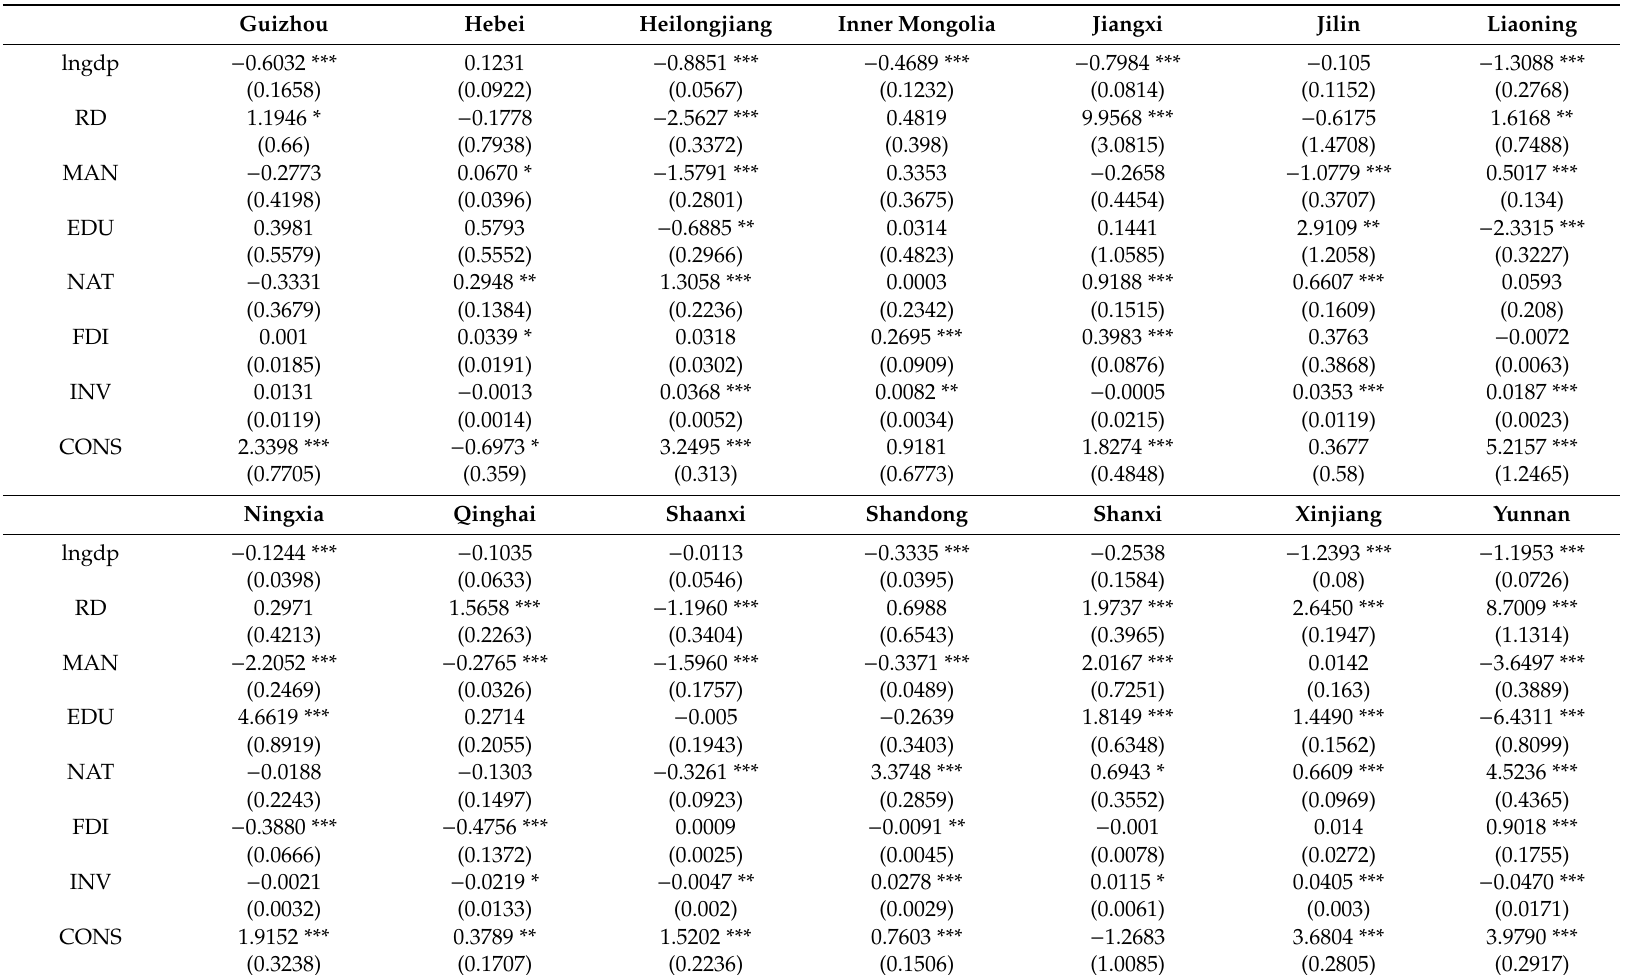
Table 4. Seemingly unrelated estimation (SUR) regressions for each